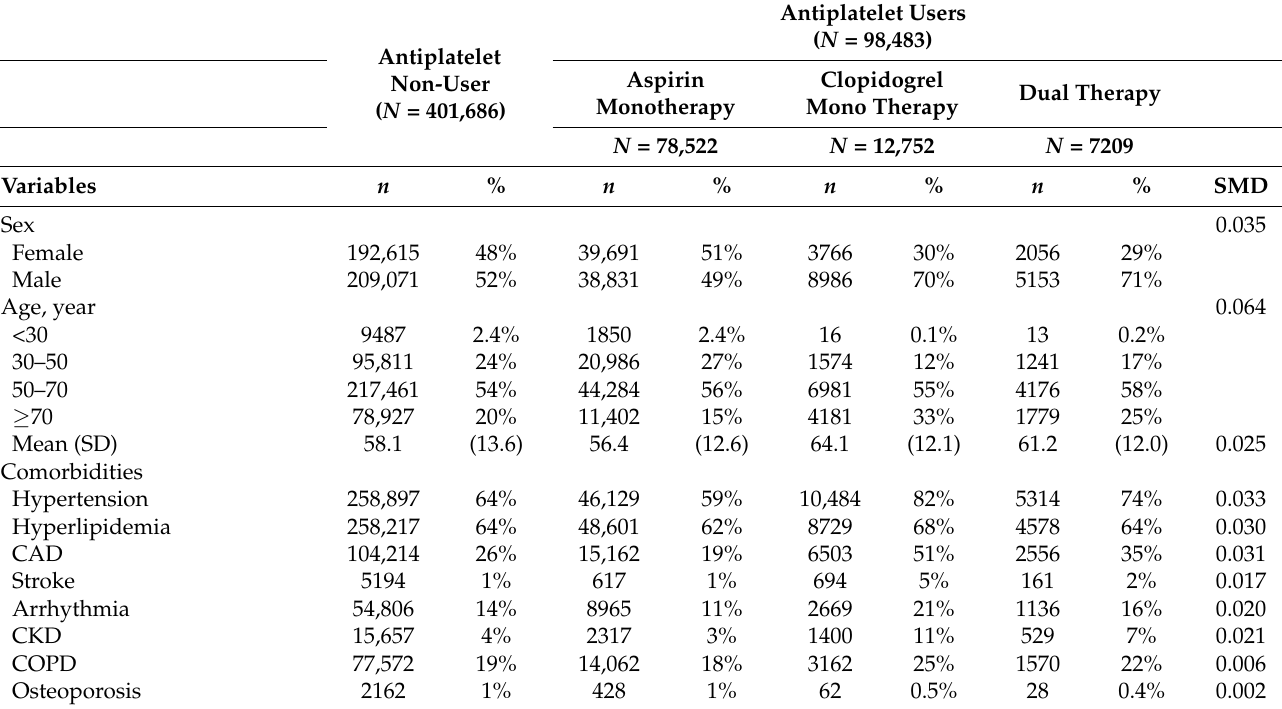
Table 1. Baseline characteristics of the four